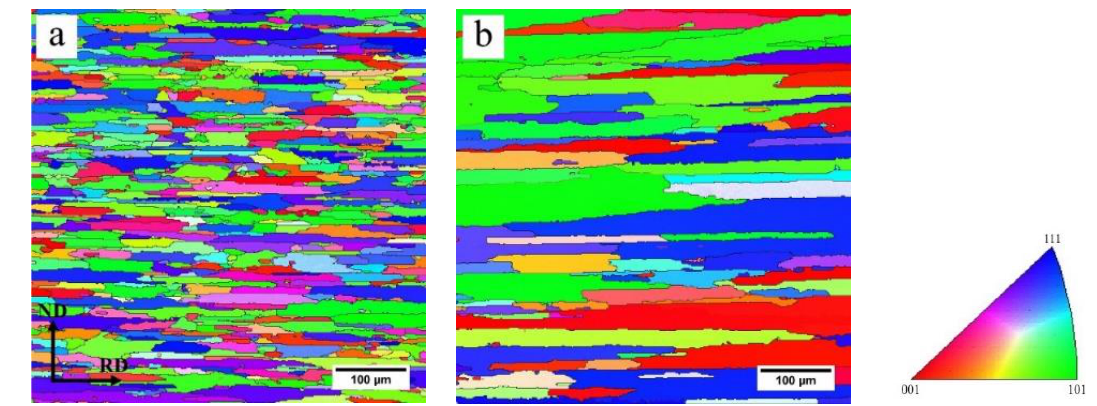
Figure 10. EBSD maps of samples after solution treatment; ( a ) FH, ( b ) SH, 50 °C/h. Table 3. The average grain size and grain aspect ratio of the FH sample and SH sample after solution treatment.